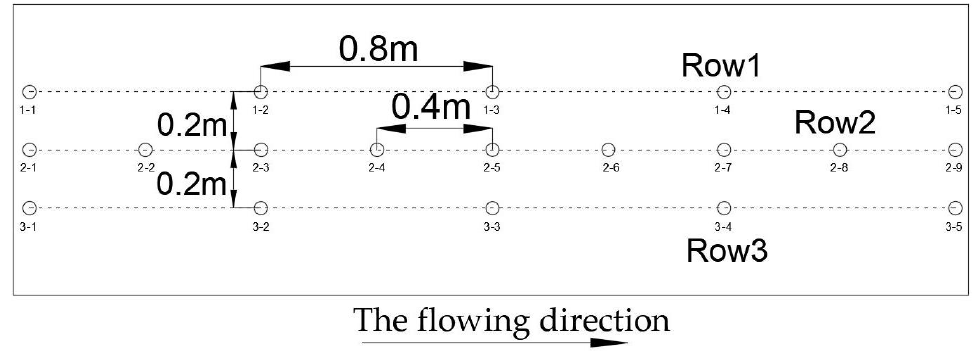
Figure 3. Illustration of sampling scheme of model test from top view.